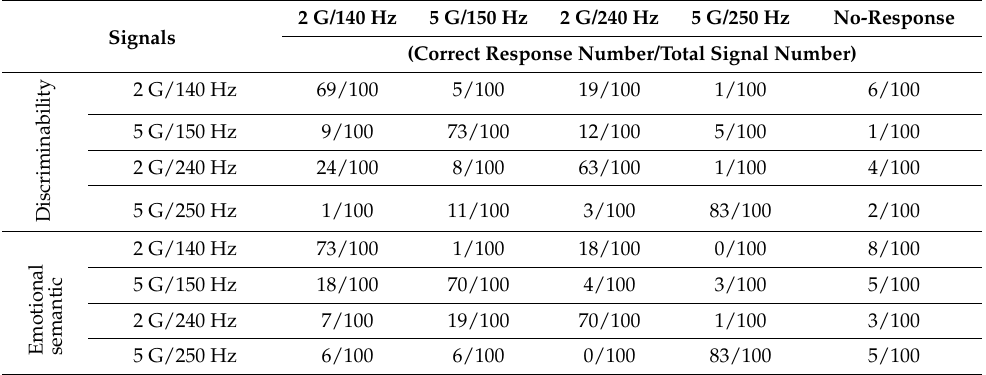
Table 12. Accuracy by haptic signals.